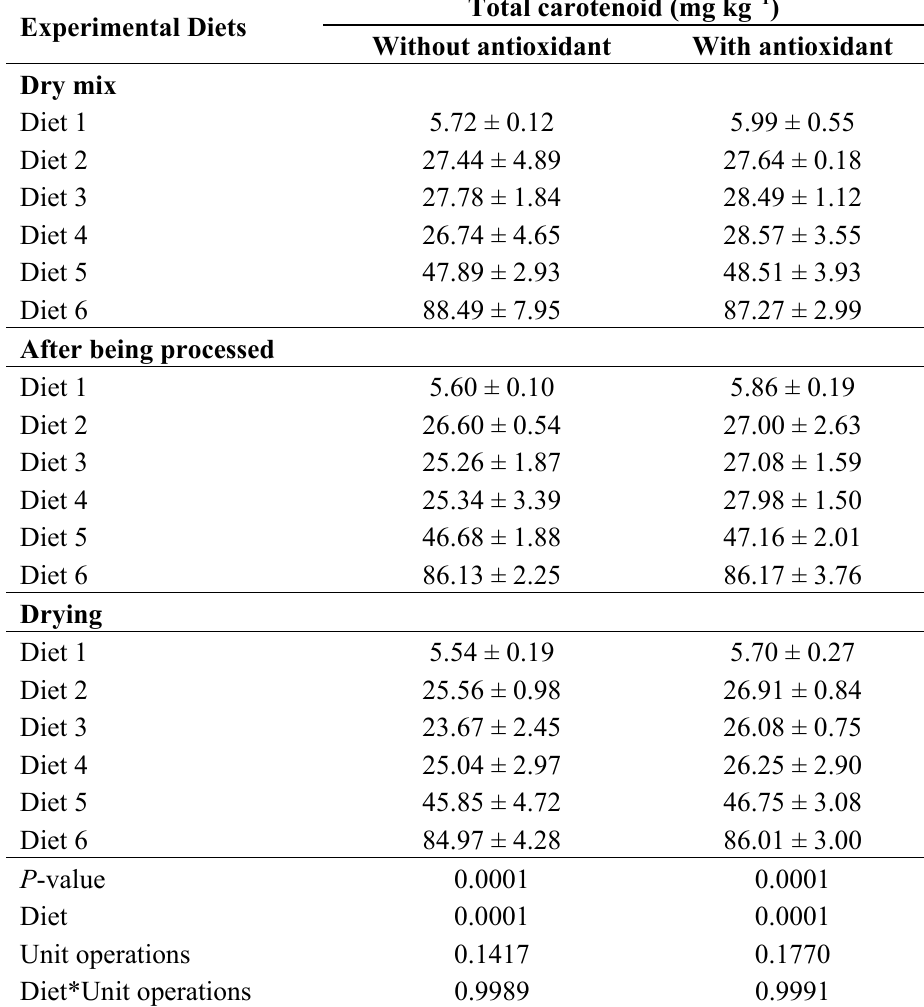
Table 1. Total carotenoids content in the experimental diets at the various unit operations.